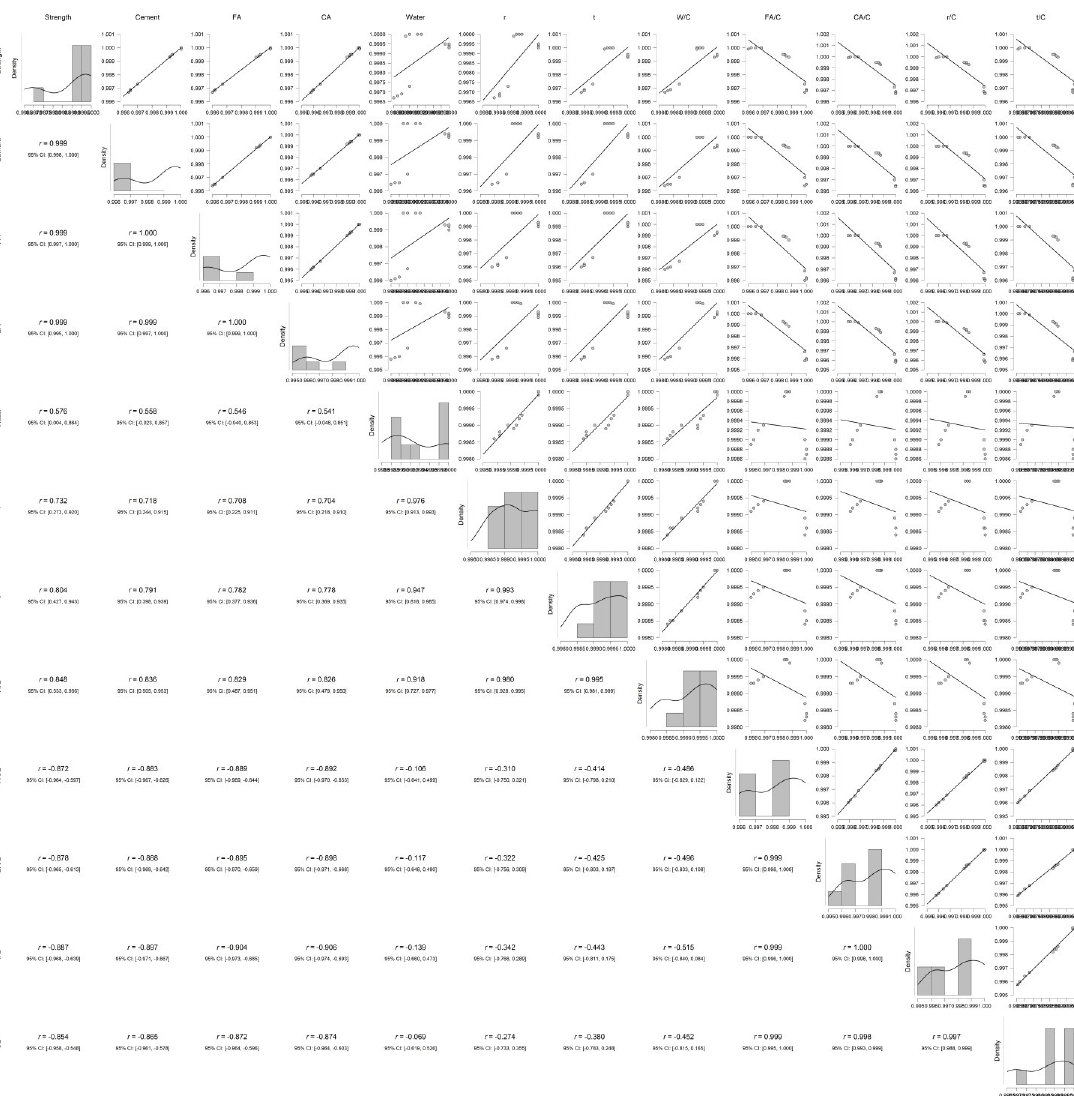
good with the results investigated from figure 2 of decom- position